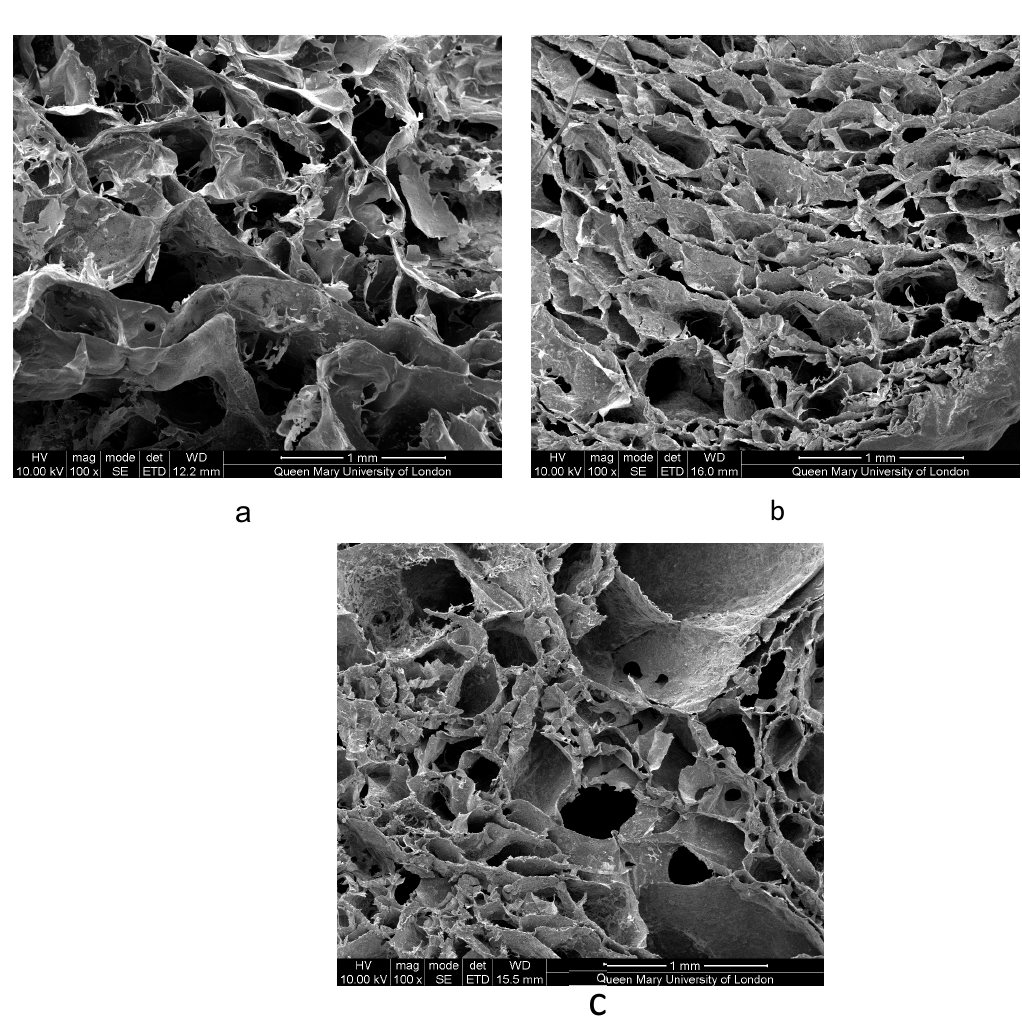
Figure 5. SEM image of the porous structure of bone scaffolds. Type 1 ( a ), type 2 ( b ), and type 3 ( c ) bone scaffolds. Scaffold Table 4. Pore size of the scaffold expressed as mean ± S.D.